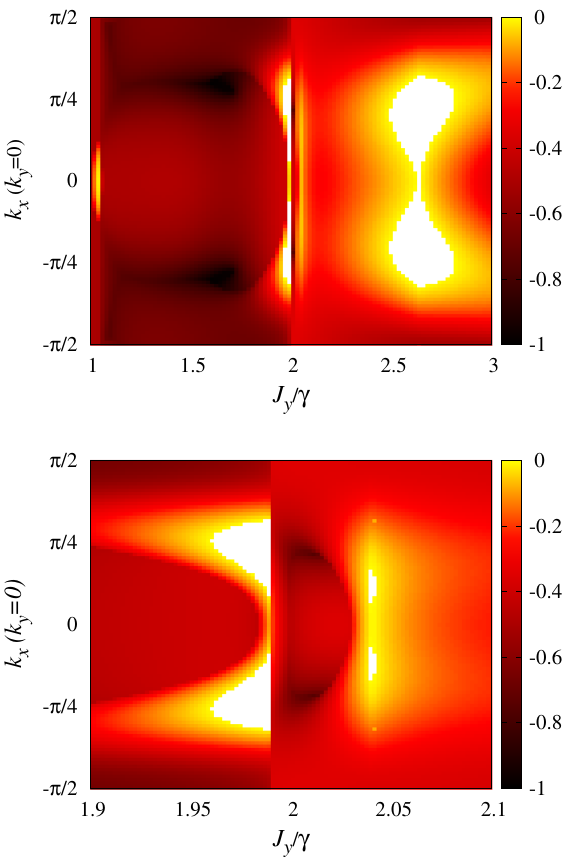
FIG. 13. Upper panel: Real part of the most unstable eigenvalue (negative is stable) as a function of J y and k x (for k y ¼ 0 ). The parameters are set as in Fig. 10. Lower panel: High-resolution plot with the same range of J y as in Fig. 12, corresponding to upward